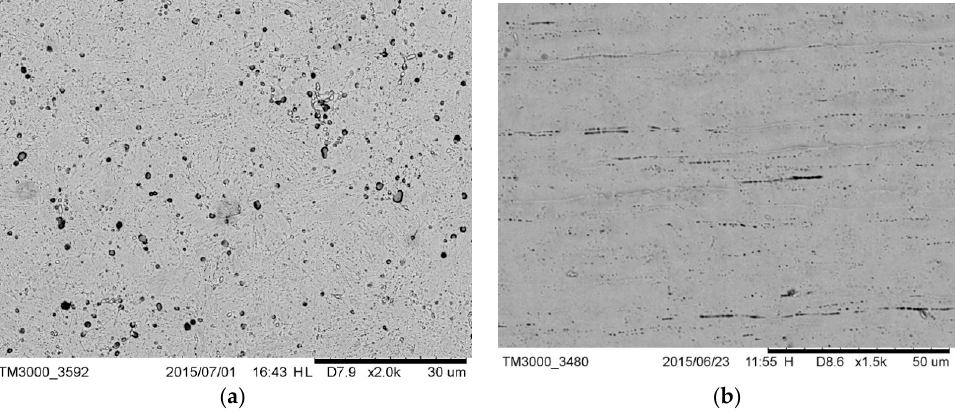
Figure 1. ( a ) Microstructure of drill C containing sulfide precipitates; ( b ) external surface of drill C; milling lines were visible.